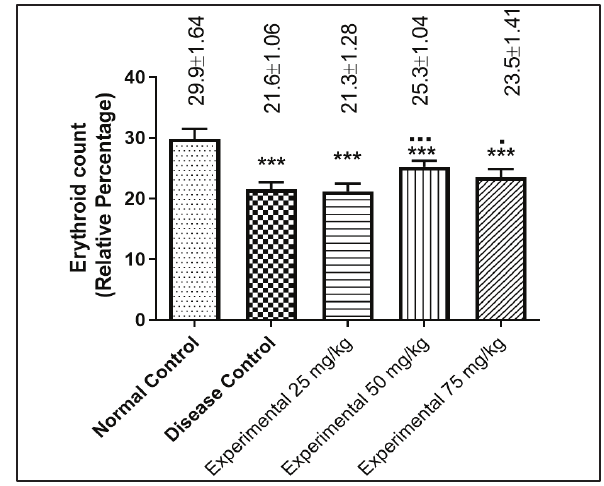
Fig-1: Effect of carboplatin and carboplatin plus 3 different doses of apple peel extract on red blood count (Mean ±SD) in mice (n=8) *** = p value <0.001 (vs Normal Control), … = p value <0.001 (vs Disease Control), .. = p value <0.01 (vs Disease Control)